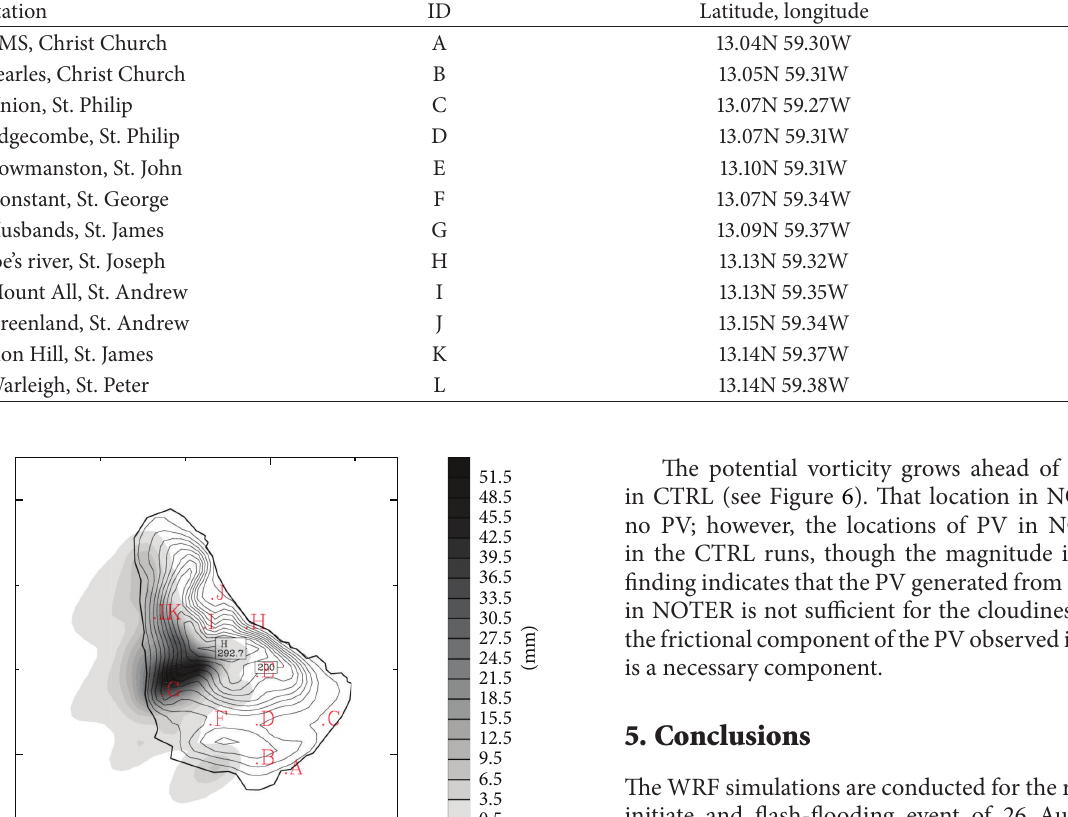
Table 2: Accumulations from stations within the rain-gauge network in Barbados. Station